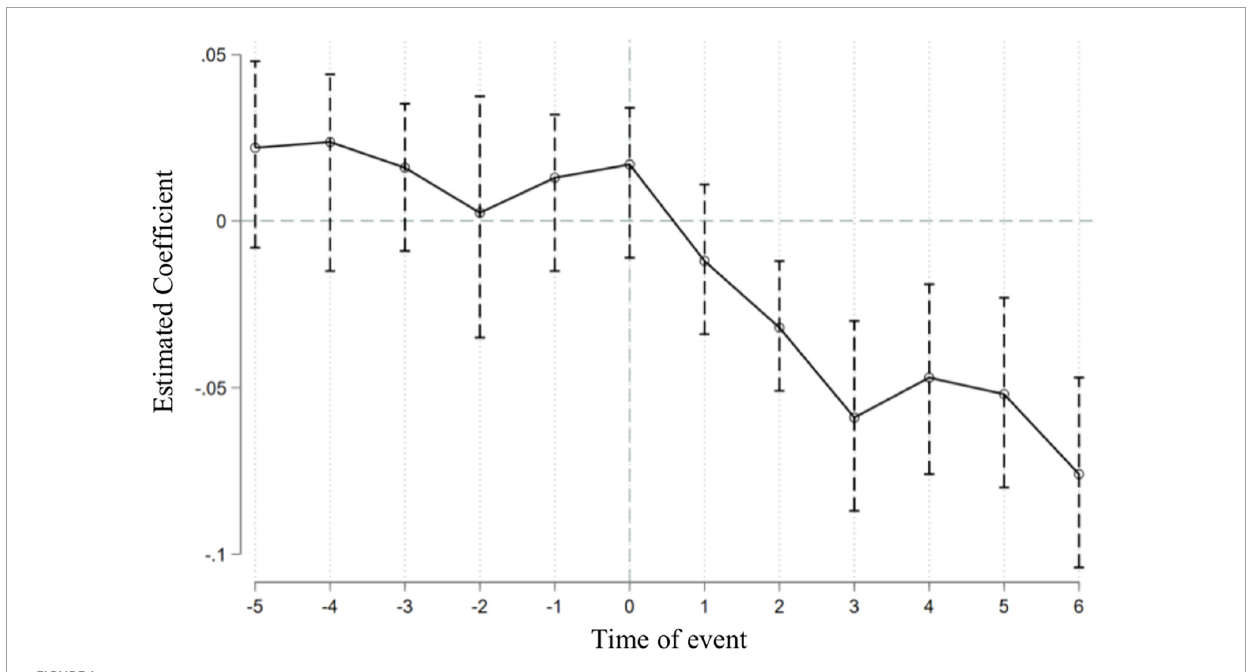
FIGURE1 Results of a parallel trend